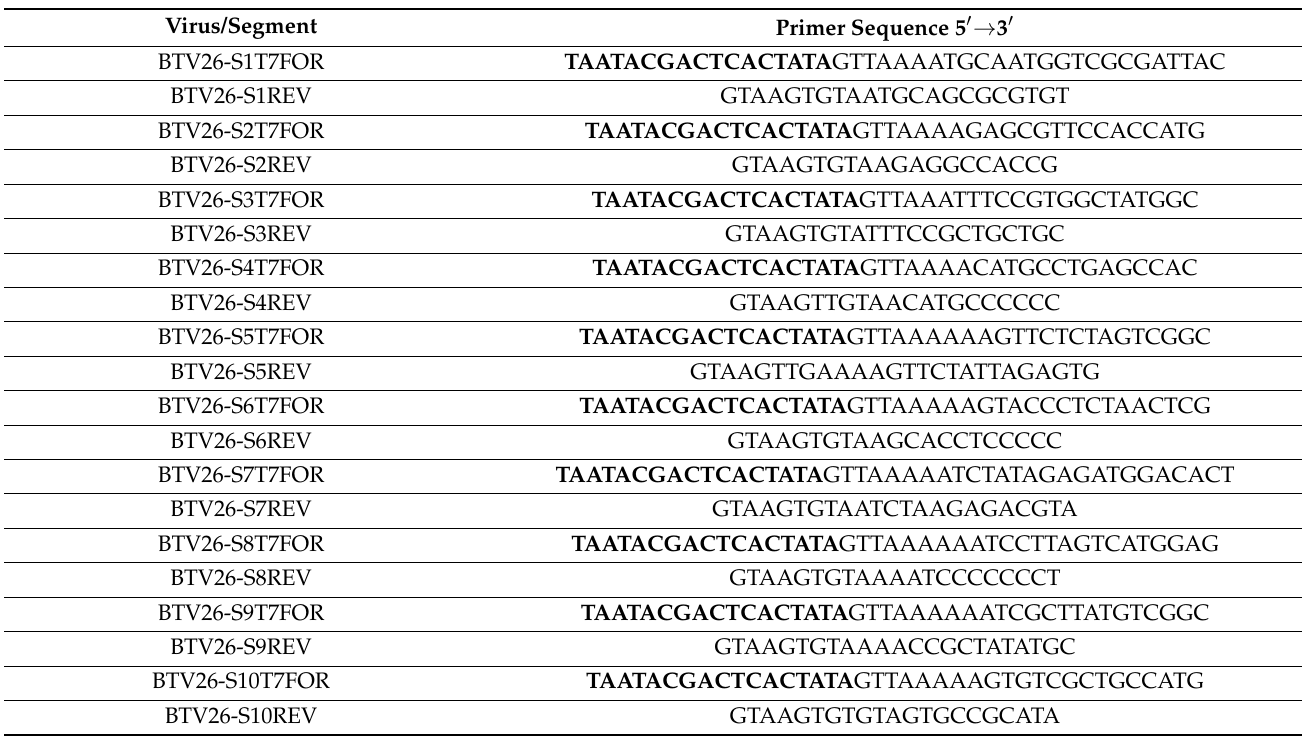
Table 2. Primers designed for PCR amplification of full-length cDNAs of genome segments 1–10 of BTV-26. The minimal T7 promoter in the forward primer is shown in